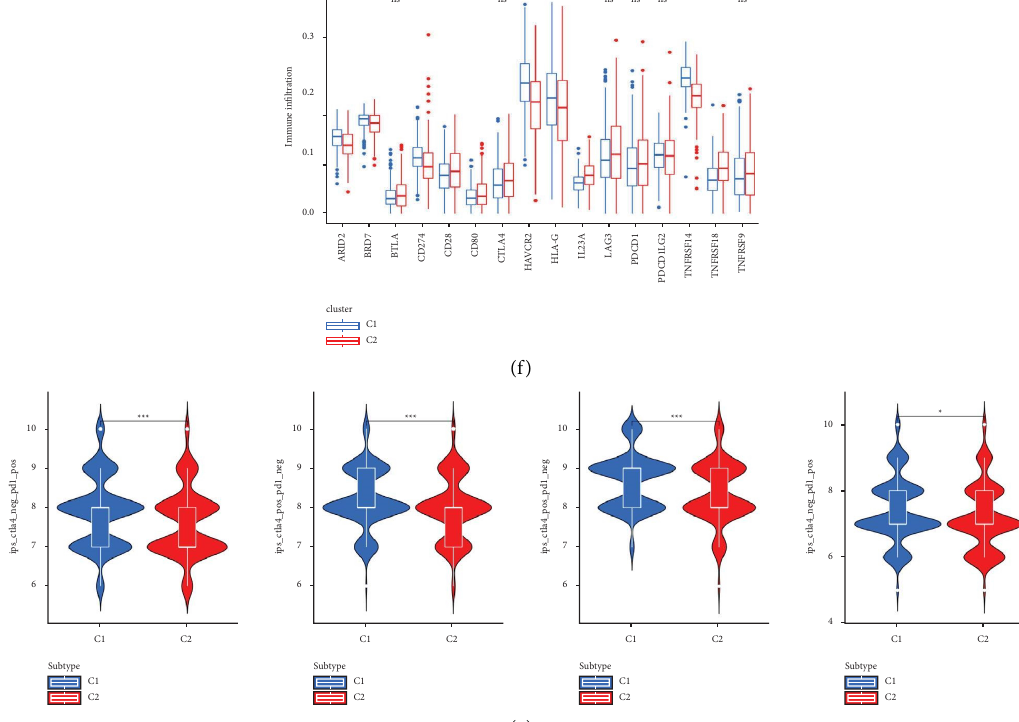
Figure 5: Identifcation of diverse TIME, immune gene pattern, and immunotherapeutic response in 2 clusters: (a) violin plots of 4 indicators of TIME between C1 and C2, including immune score, stromal score, ESTIMATE score, and tumor purity; (b) K–M survival analysis for high and low TIME score ccRCC patients; (c) scatter plots of the correlation between immune, stromal score and tumor purity; (d) bar plots of the results of functional enrichment analysis; (e) box plots of the abundances of diferent infltrating immune cells; (f) box plots of the expression levels of immune checkpoints; and (g) violin plots of the immunotherapy